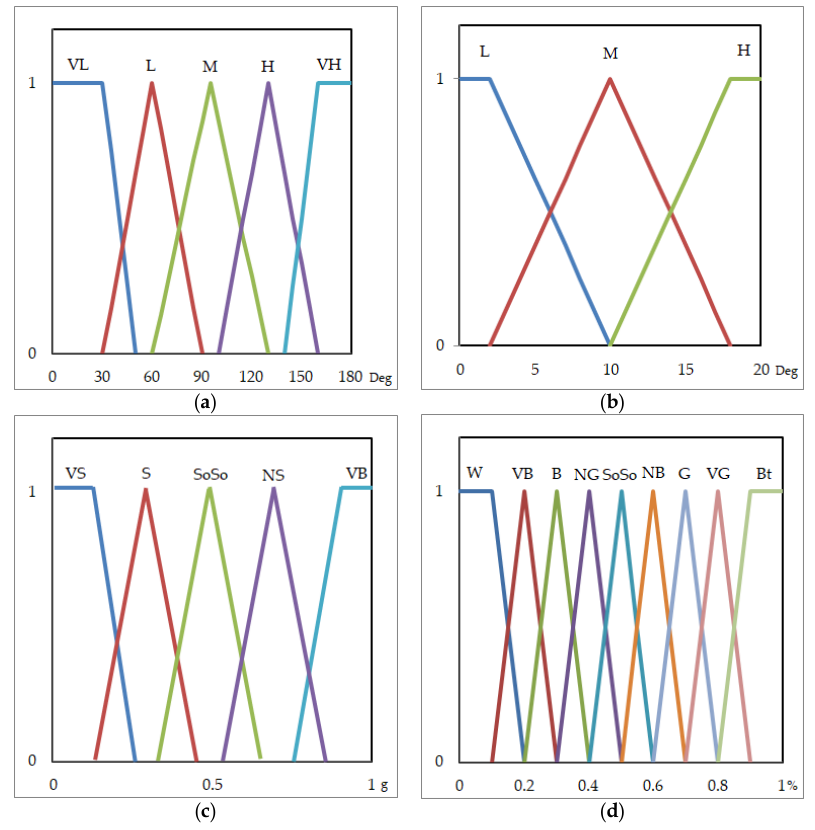
Figure 9. Flexion and Pronation MFs ( a ) FAA, PAA ( b ) FASD, PASD ( c ) FLS, PVS ( d ) FMR,